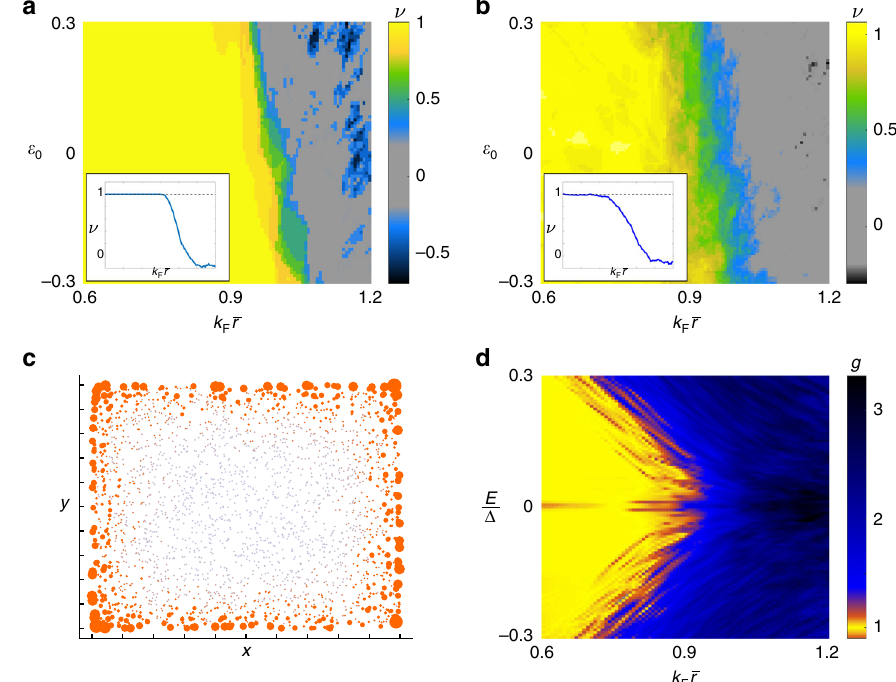
Fig. 2 Topological superconductivity in the Shiba glass. a Topological phase diagram for a ferromagnetic Shiba glass as a function of the single-moment bound-state energy ε 0 and the characteristic length between the moments r ¼ ρ (cid:1) 1 2 , where ρ is the moment density per unit area. The colour bar indicates ξ ¼ 4 π the value of the Chern number. The adatom number is held fi xed at 600, with k and λ = 0.2. The displayed diagram is an average over 10 F 5 con fi gurations. Inset: Line along ε 0 = 0.1, averaged over 500 con fi gurations. b Same as in a , but for magnetic moment directions drawn from the Boltzmann distribution with β E Z = 10 and averaged over 30 con fi gurations, and with the number of moments fi xed at 900. The deviation from the quantised values and the width of the transition region diminish as the system size is increased. c Local density of states (LDOS) for a 12.5 ξ × 12.5 ξ square Shiba glass system comprising 2500 randomly distributed sites, integrated over subgap energies E j j < 0 : 1 Δ . Parameters used same as in a , with onsite energy ε 0 = 0. The areas of the orange discs correspond to the magnitude of the LDOS; each site is additionally represented by a grey point which is visible when the LDOS is negligible. d The thermal conductance (in units of π k 2 B T ) along the line ε 0 = 0 for the same system parameters as in the previous fi gures, but with 3 (cid:1) h 2500 adatoms. The vertical width of the conduction plateau (yellow) corresponds to the mobility gap of the system, and can be seen to close as the